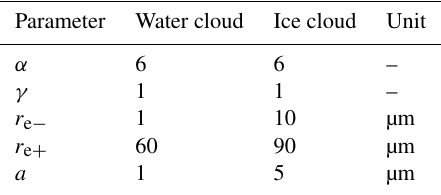
Table C1. Parameters used to quantise the cloud particle radius ac- cording to Eq.